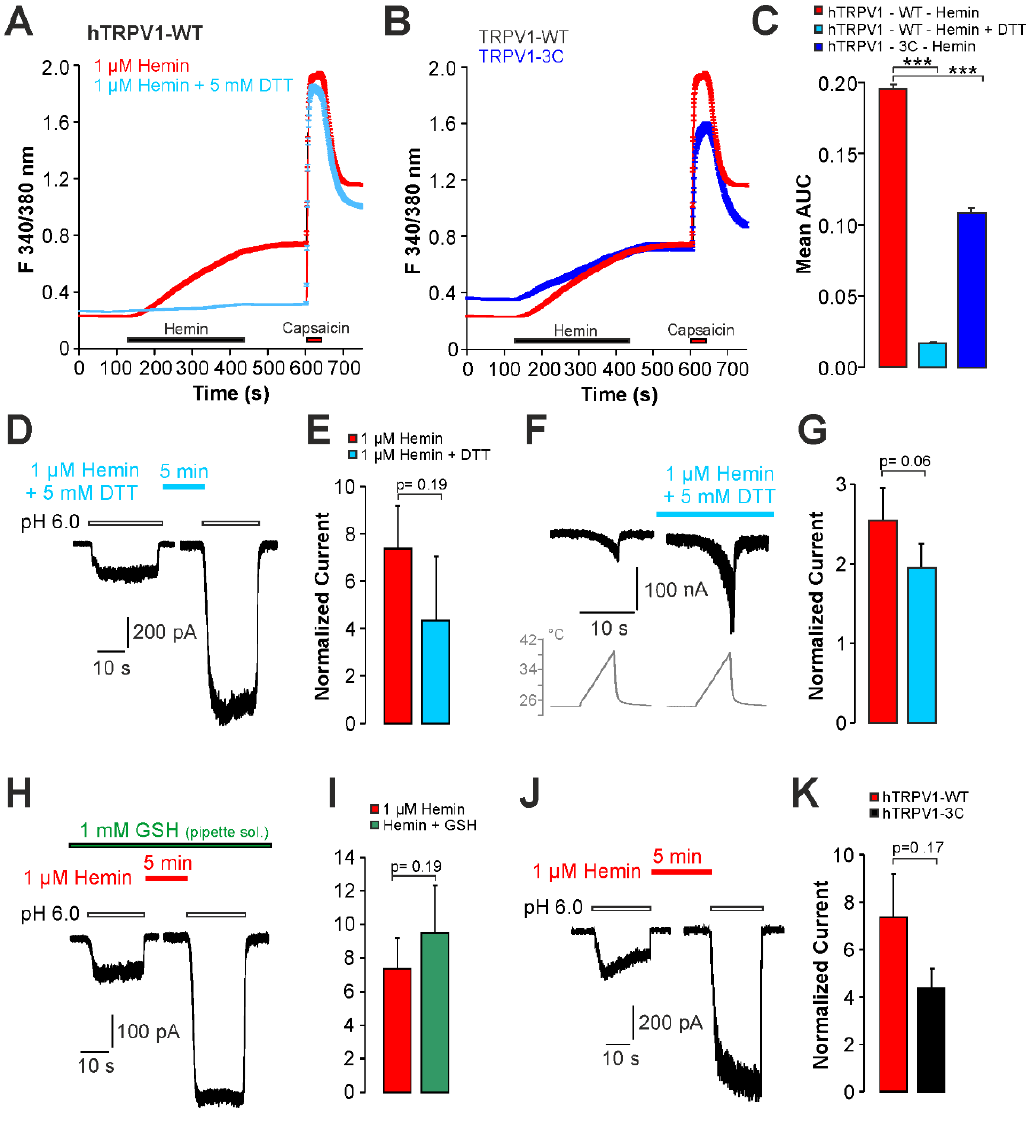
Figure 6. Hemin-induced increase in intracellular calcium is redox-dependent. ( A ) Mean calcium responses in cells expressing hTRPV1-WT treated with 1 µM hemin or hemin together with 5 mM DTT. ( B ) Mean calcium responses in cells expressing hTRPV1-WT or hTRPV1-3C treated with 1 µM hemin. In ( A,B ), capsaicin (1 µM) was applied to verify expression of hTRPV1. ( C ) Area under the curve (AUC) for hemin-induced increase in fluorescence ratio described in ( C,B ). ANOVA F(2, 2117)=88.167, p < 0.001. ( D ) Patch clamp recordings on hTRPV1-WT-expressing cells challenged with two consecutive applications of pH 6.0 with 1 µM hemin and 5 mM DTT applied for 5 min between applications of protons. ( E ) Mean peak amplitudes of inward currents evoked by pH 6.0 in ( C ) as well as of cells treated with hemin alone. The bars display normalized amplitudes of the currents resulting from the second application of pH 6.0. ( F ) Heat-evoked inward currents in cells expressing hTRPV1-WT. Following the first heat-evoked current, cells were treated with 1 µM hemin in combination with 5 mM DTT. The depicted current was recorded after 6 min. ( G ) Mean normalized peak amplitudes of inward currents evoked by heat in ( E ) and for cells treated with hemin only. ( H ) Proton-evoked inward currents on hTRPV1-WT treated with 1 µM hemin together with 1 mM GSH (in the patch pipette). ( I ) Mean peak amplitudes of inward currents evoked by pH 6.0 in ( G ) as well as of cells treated with hemin. The bars display normalized amplitudes of the currents resulting from the second application of pH 6.0. ( J ) Representative trace of proton-evoked inward current on hTRPV1-3C treated with 1 µM hemin for 5 min between two applications of pH 6.0. ( K ) Mean peak amplitudes of inward currents evoked by pH 6.0 in ( I ) as well as of cells expressing hTRPV1-WT. The bars display normalized amplitudes of the currents resulting from the second application of pH 6.0. Cells were held at − 60 mV in all patch clamp experiments. Data are shown as mean ± S.E.M. *** denotes p< 0.001.